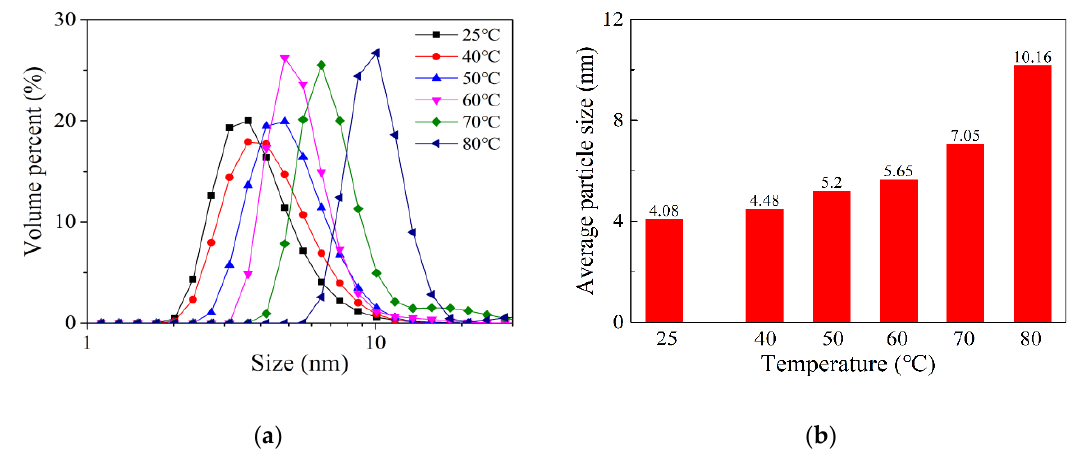
Figure 2. The size of iron colloidal particles prepared at different temperatures: ( a ) size distribution; ( b ) average size.